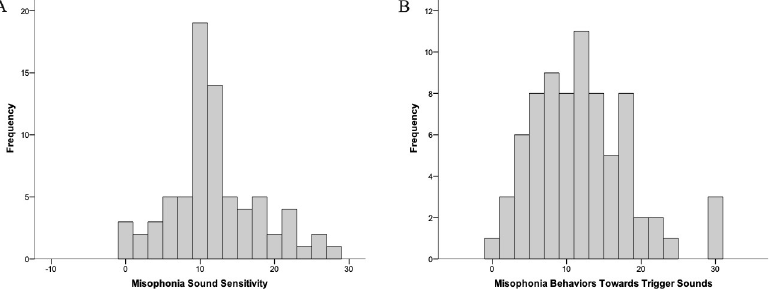
Fig 1. Distribution of Scores for MQ Sound Sensitivity (1a) and MQ Emotional Behaviors Towards Trigger Sounds